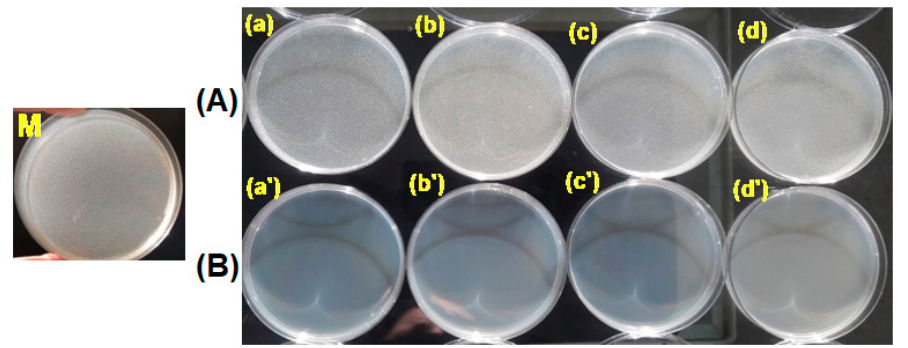
24 h, compared to control sample (M). ( B ) T 2 =